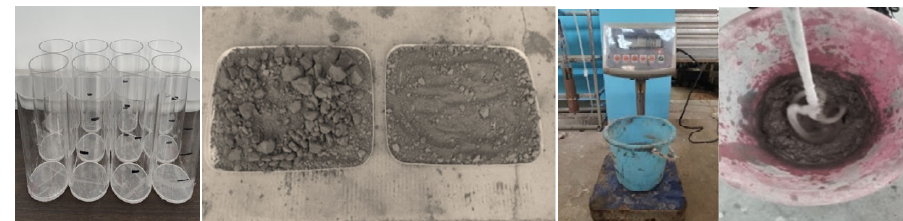
Figure 2. Preparation of experimental filling material.